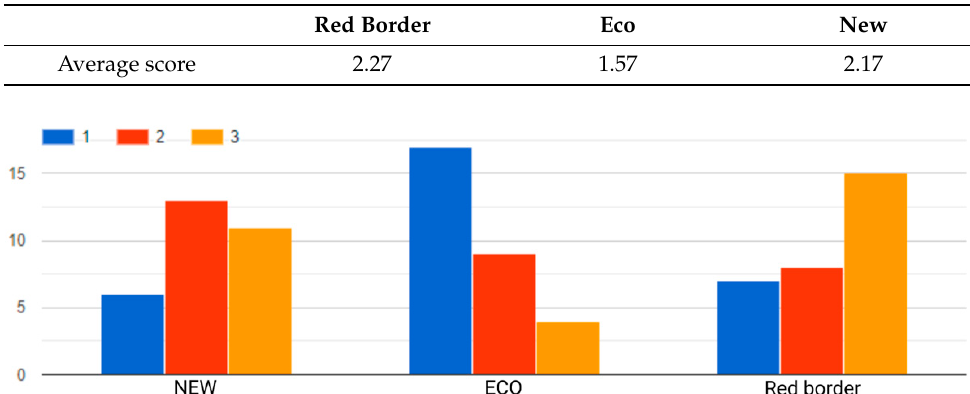
Figure 9. Highlight type impact survey results. Histogram of responses broken down by the impact on product perception. Scores were assigned from 1 point (smallest impact) up to 3 points (greatest impact).